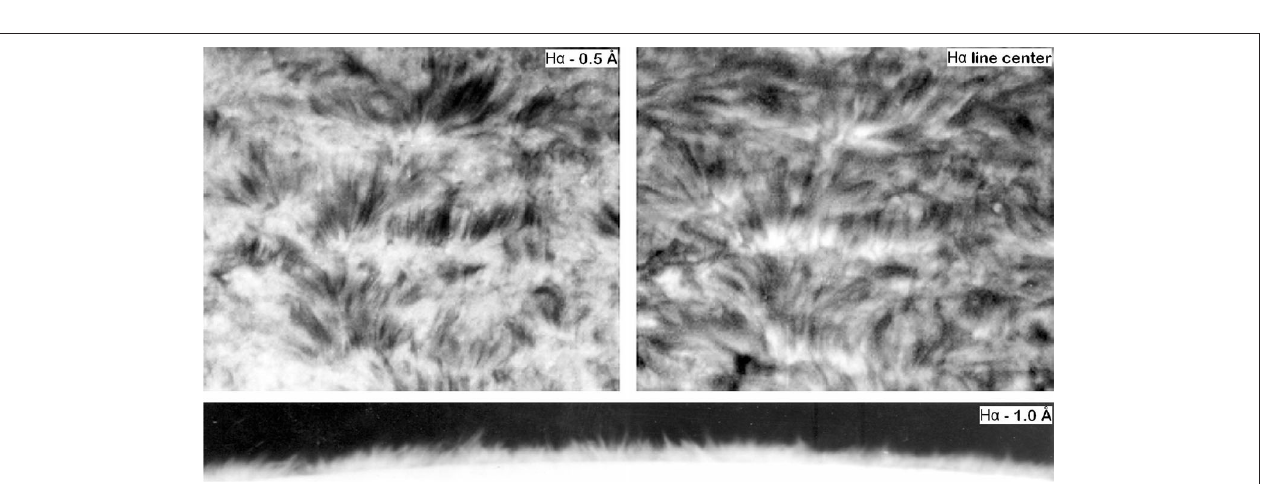
FIGURE 8 | Line of sight magnetic field from HMI/SDO (left), intensity in the He II 304Å band (middle) and in the Fe XII 193Å band (right) from AIA/SDO. Same region as in Figure 6 . Images produced by the author.